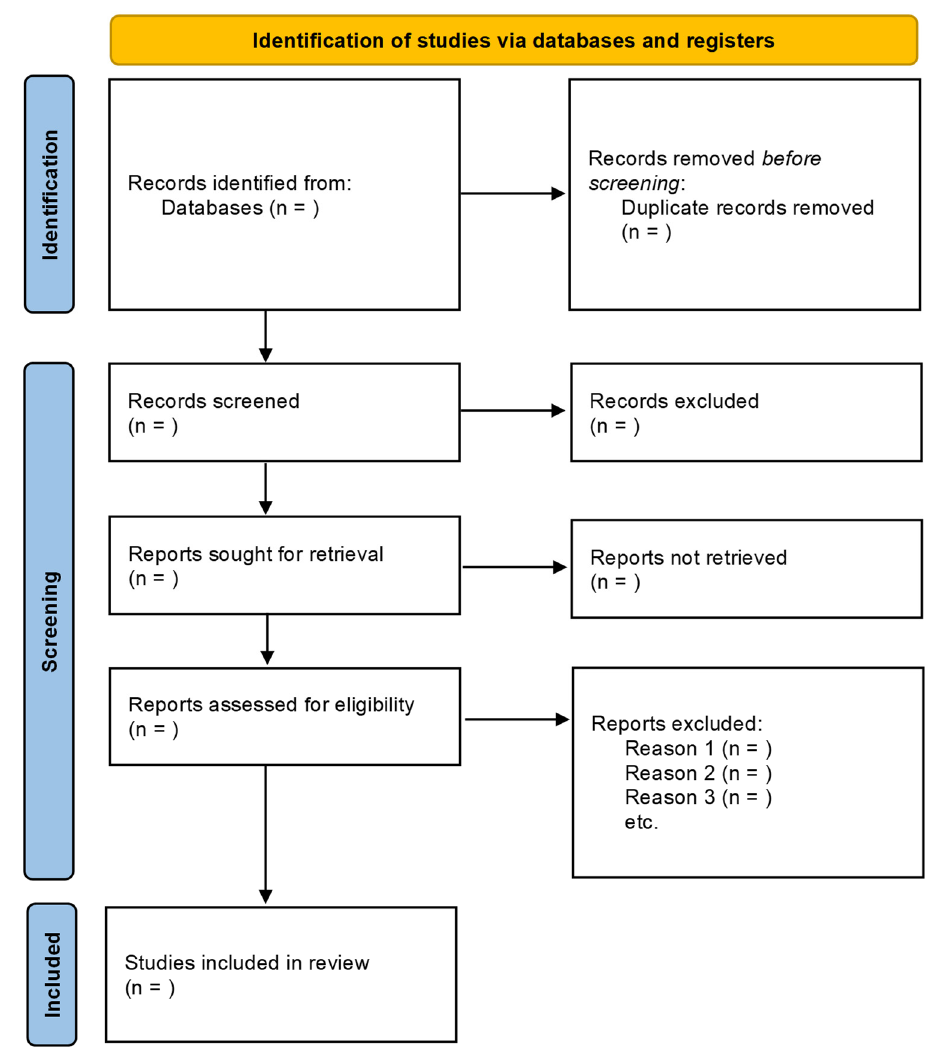
Figure 1. PRISMA 2020 generic flow diagram for new systematic reviews.